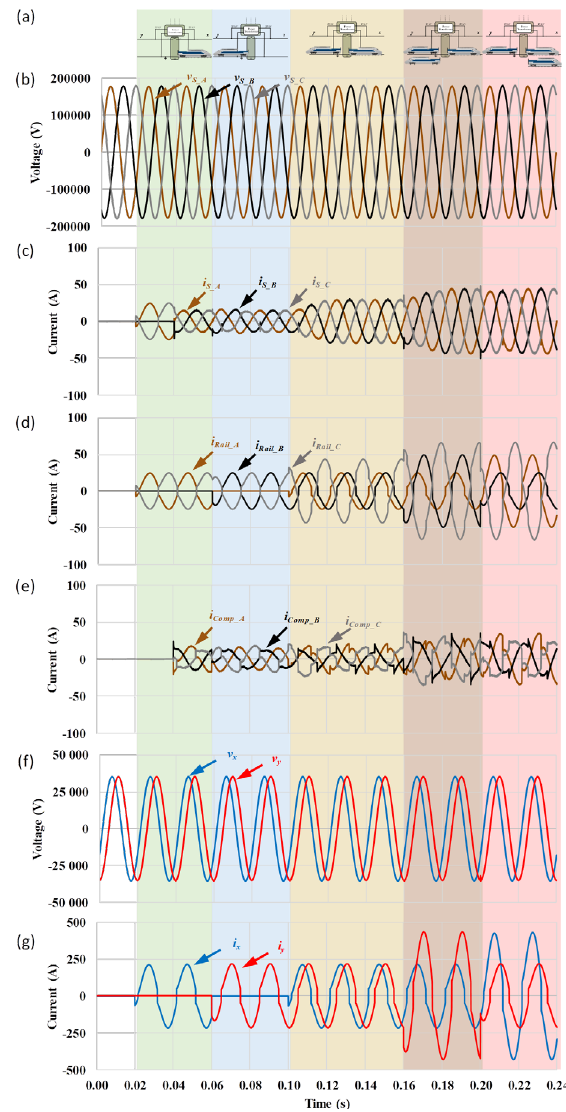
Figure 7. Simulation results of the STATCOM compensating the power quality problems existing in the railway system powered by a V/V power transformer: (a) Case scenarios with